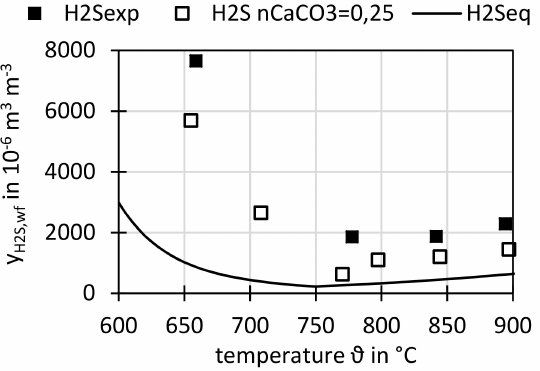
Figure 12. Measured and equilibrium H 2 S concentration on dry and N 2 -free basis at different temperatures ϑ .